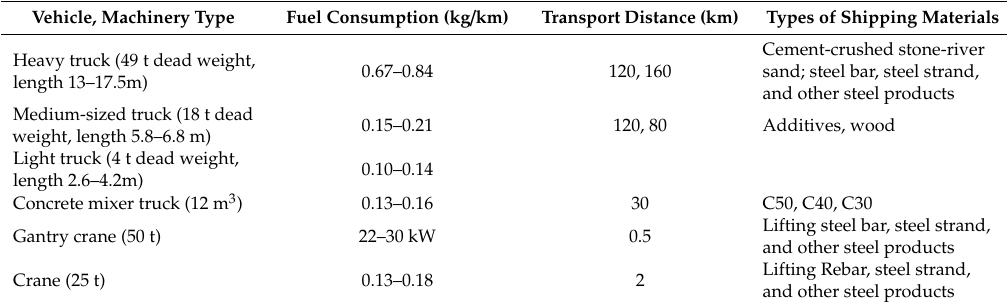
Table 2. The statistical table of used machinery and equipment at each stage